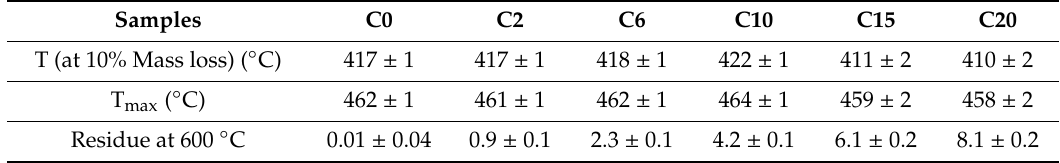
Figure 7. Thermograms of pure LDPE80/HIPS20 and of the different concentrations (2, 6, 10, 15, 20 wt %) of TWP loaded LDPE/HIPS/TWP composite films: ( a ) TGA; and ( b ) DTG. Table 5. Thermogravimetric results of polymer composites.